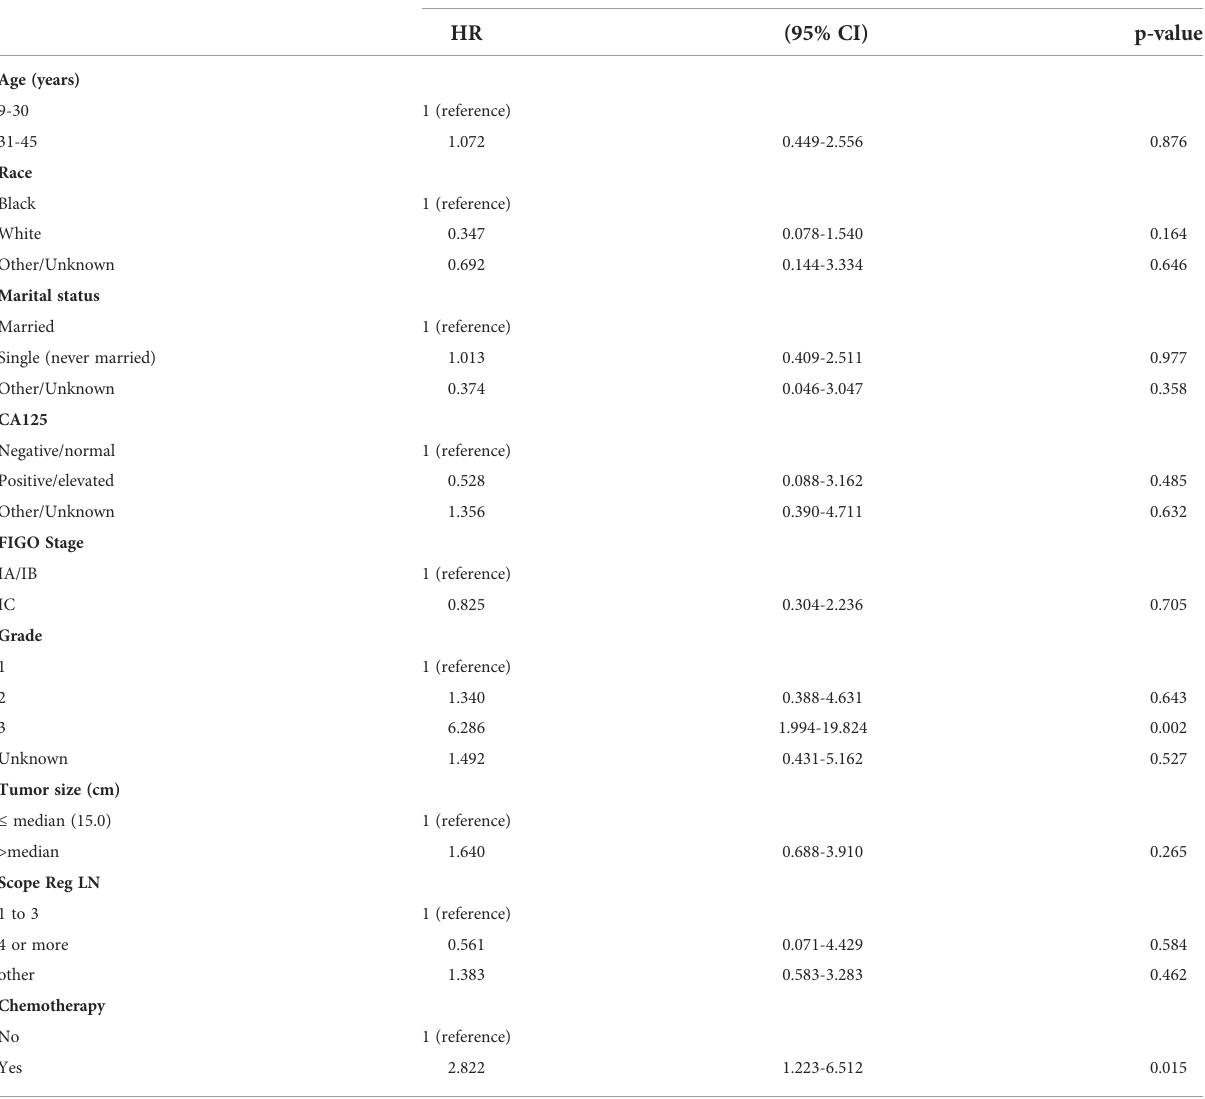
TABLE 3 Univariate analysis of cancer-speci fi c survival among stage I MOC patients with FSS.